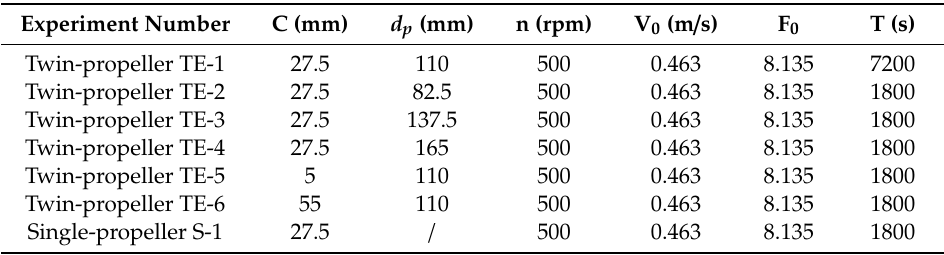
Table 1. Experiment Test Set.